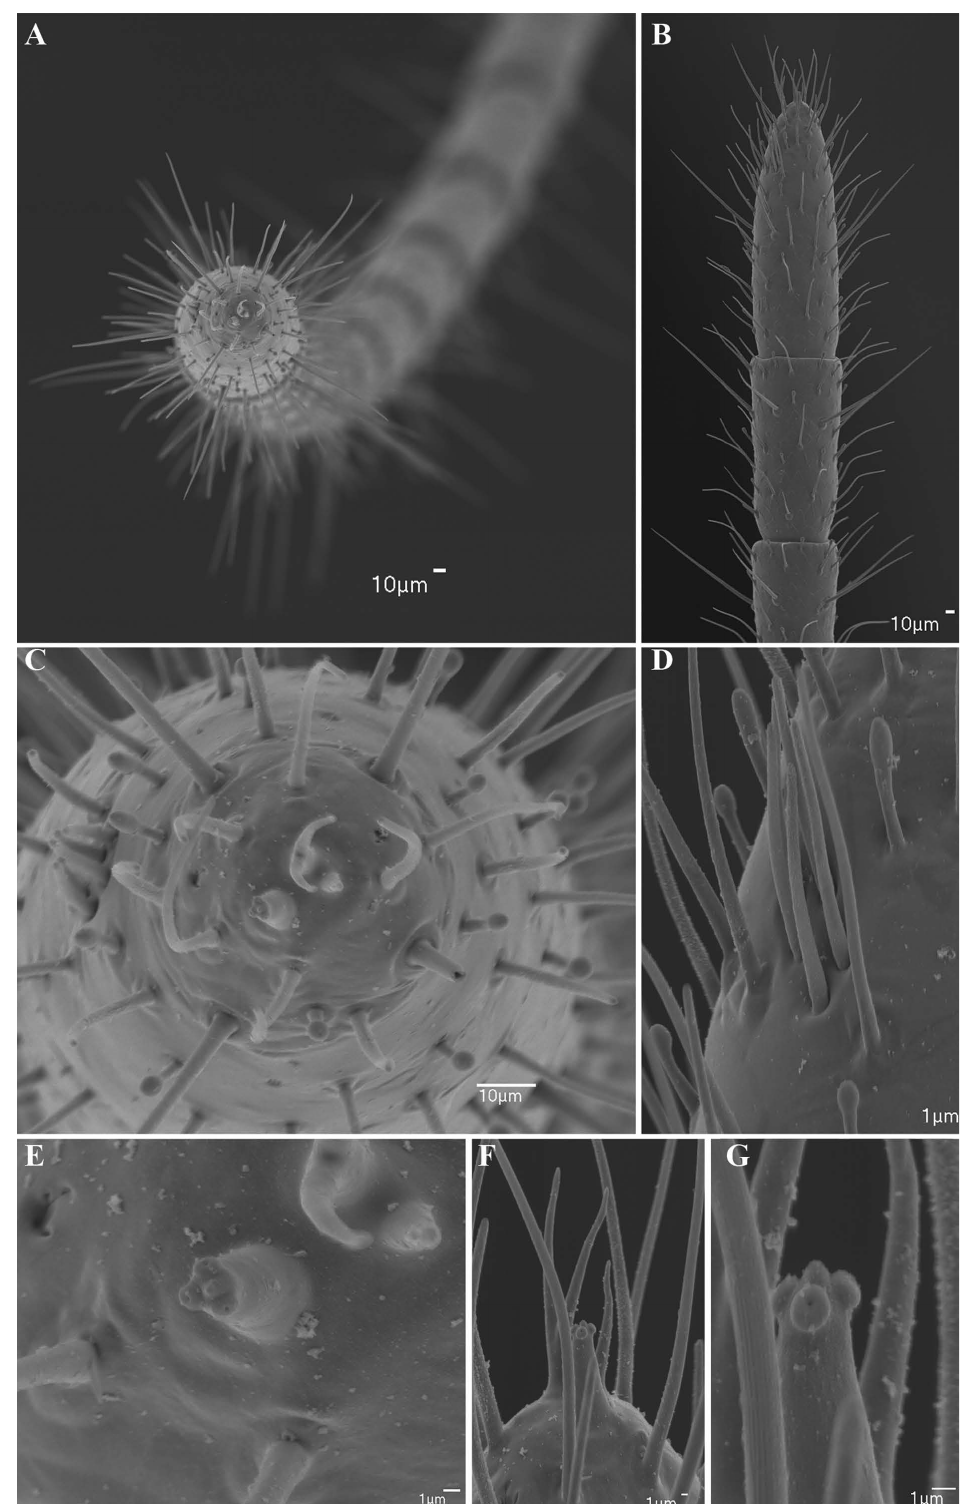
Fig. 100. Charinus neocaledonicus Kraepelin, 1895 (AMNH), antenniform leg I, ♀ . A . Apex of distal article of tarsus. B . Two distalmost articles, lateral view. C . Distal article of tarsus, frontal view. D . Olfactory setae ventral surface of last article of tarsus. E . Tarsal organ near tarsal claw. F . Claw and tarsal organ, lateral view. F . Tarsal organ, lateral